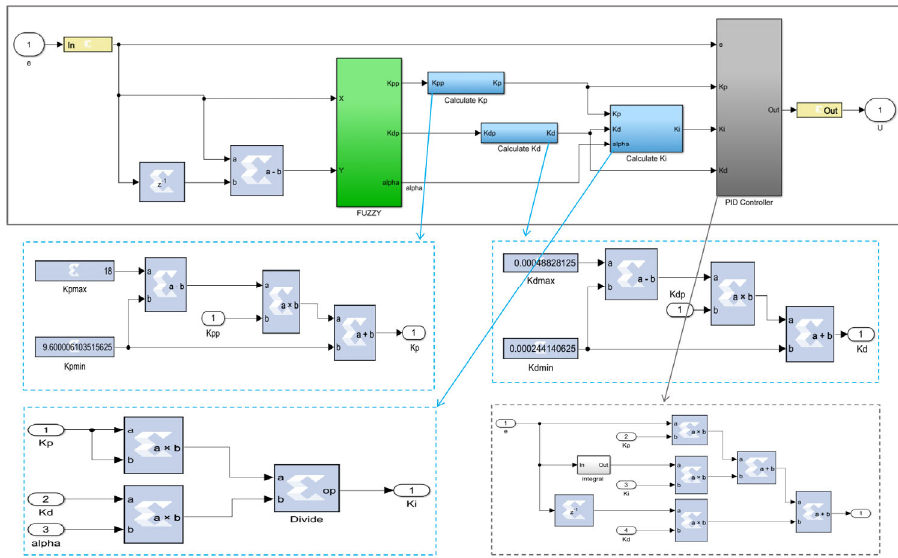
Figure 18. Hardware design of FGS-PID.